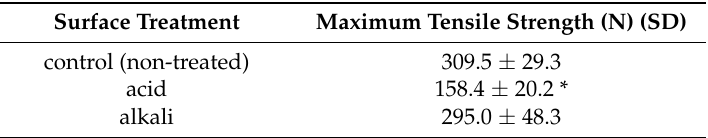
Table 2. Tensile strength of samples.